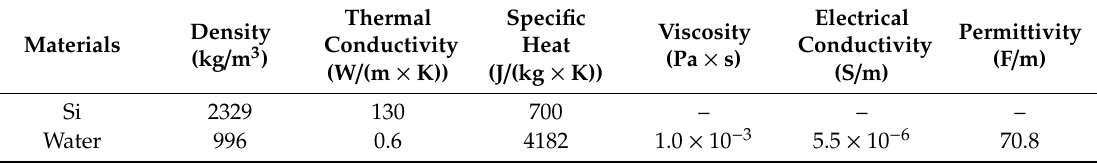
Table 4. Thermophysical properties of silicon and deionized